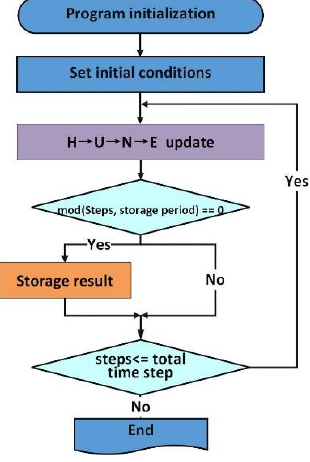
Figure 2. Serial program flow chart.